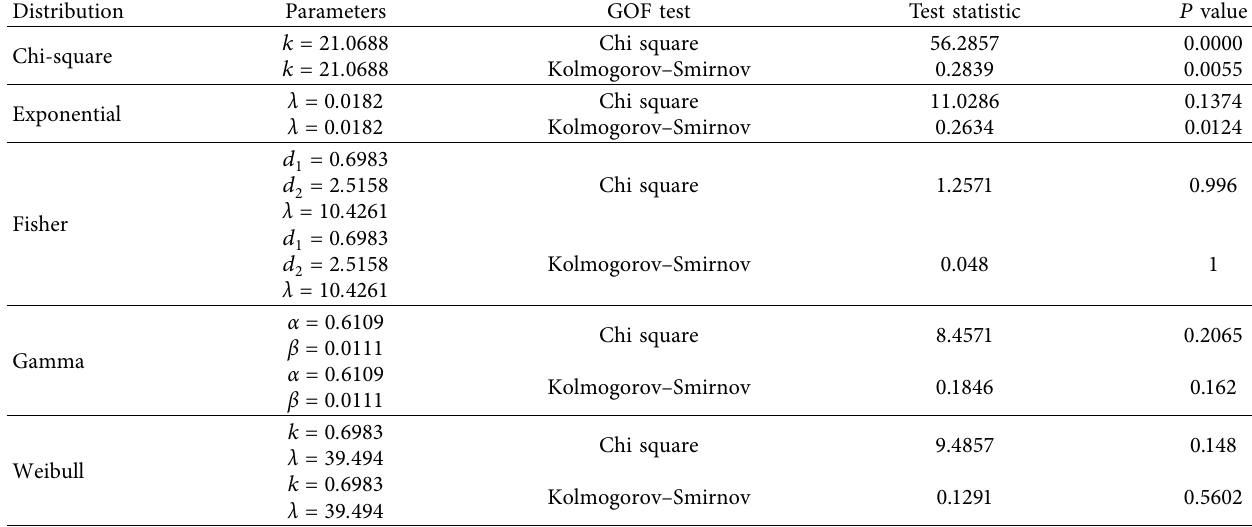
Table 14: Cyber-related fraud loss frequency distribution of GOF tests.